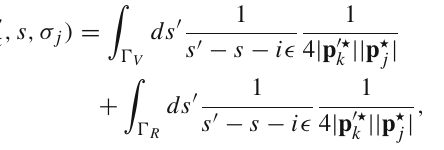
Fig. 10a shows the RPE and VPE contours, (cid:16) R and (cid:16) V , respectively. Note that in the logarithmic representation, the RPE cut is circular, whereas in the dispersive repre- as long as singularities are not crossed. decreases below the inversion point σ above the real axis. The RPE cut directly connects s ( + ) to s without crossing the real axis. This is the typi- kj cle, illustrated in Fig. 10b. Note that when σ (cid:6) equal masses m j = m k , then the integrand branch points merge into pole singularities. RPE branch points again wrap around the real axis,